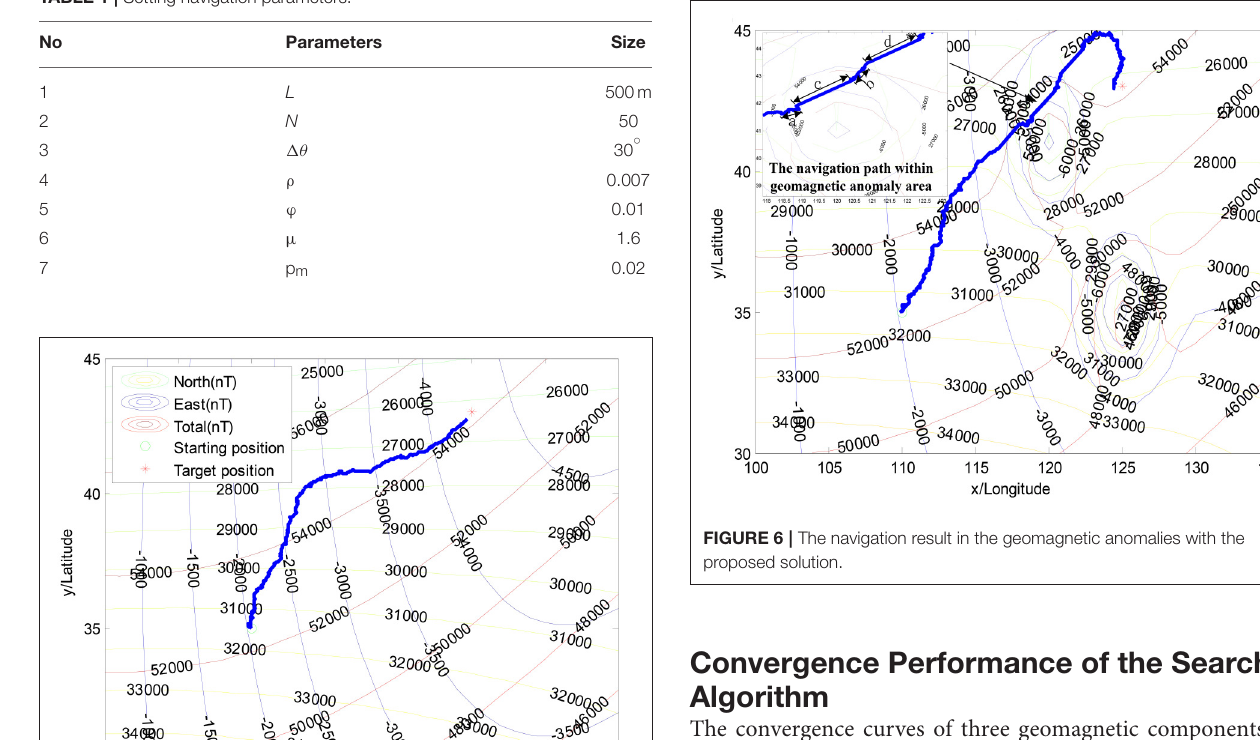
abnormal regions. Then, the statistic characteristics of the convergence state is utilized to the behavior constraints, for the purpose of jumping out the abnormal region.